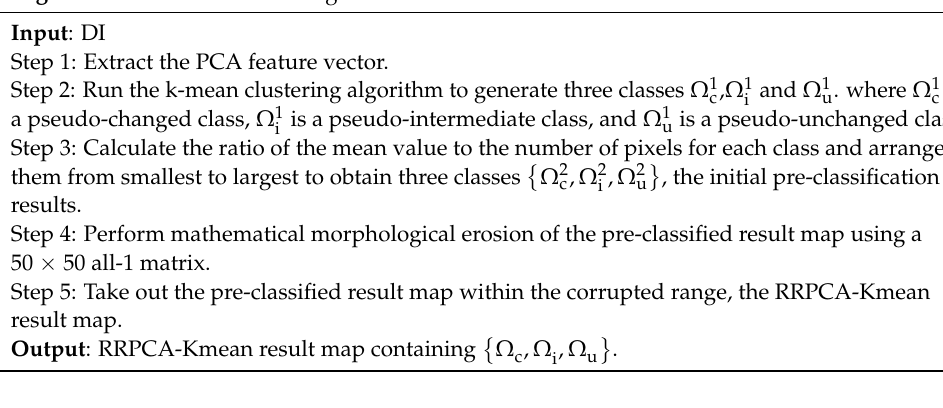
Algorithm 1 RRPCA-Kmean Algorithm